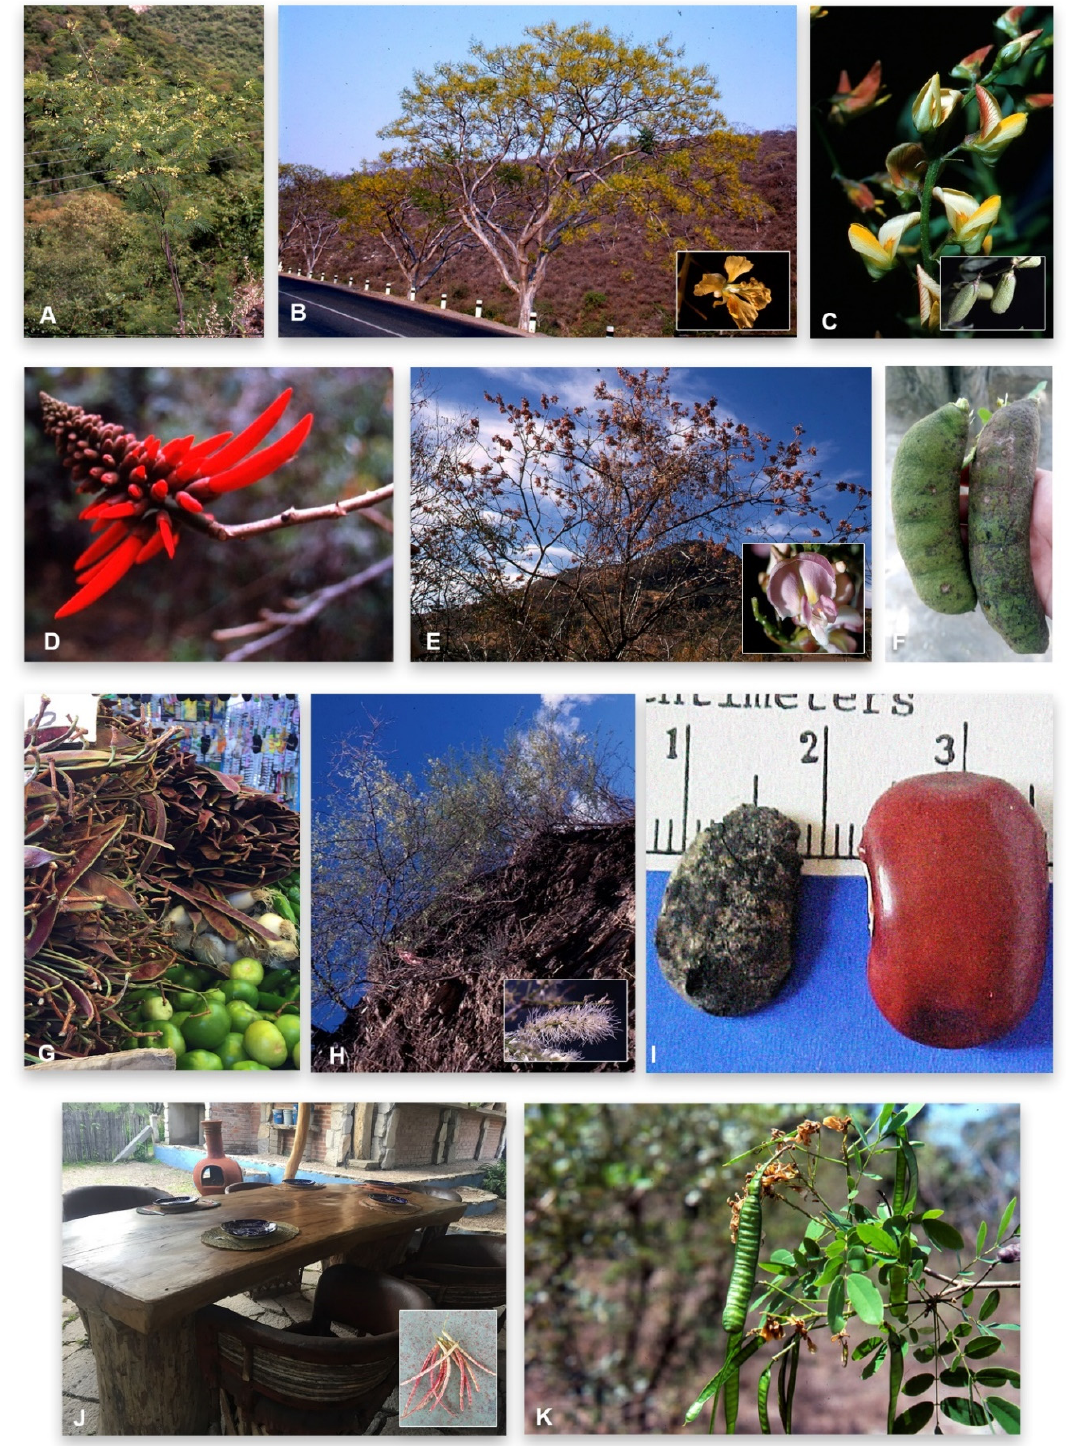
Figure 1. A selection of useful Mexican legumes. ( A ) Acaciella angustissima (firewood and medicinal); ( B ) Conzattia multiflora (edible fruit); ( C ) Crotalaria pumila (edible and medicinal leaves); ( D ) Erythrina americana (edible flowers and environmental uses); ( E ) Gliricidia sepium (multipurpose species); ( F ) Ebenopsis ebano (firewood and environmental uses); ( G ) Leucaena leucocephala (edible seed); ( H ) Mimosa polyantha (firewood and materials); ( I ) Phaseolus coccineus (archeological and contemporary cultivated seeds); ( J ) Prosopis laevigata (table made in Guanajuato, Mexico); ( K ) Senna racemosa (medicinal bark). Credits: ( A – E , H , K ) J. Vazquez’ Slide Collection at MEXU; ( F ) D. Mart í nez Almaguer; ( I ) A. Delgado; ( G , J ) L. Torres- Col í